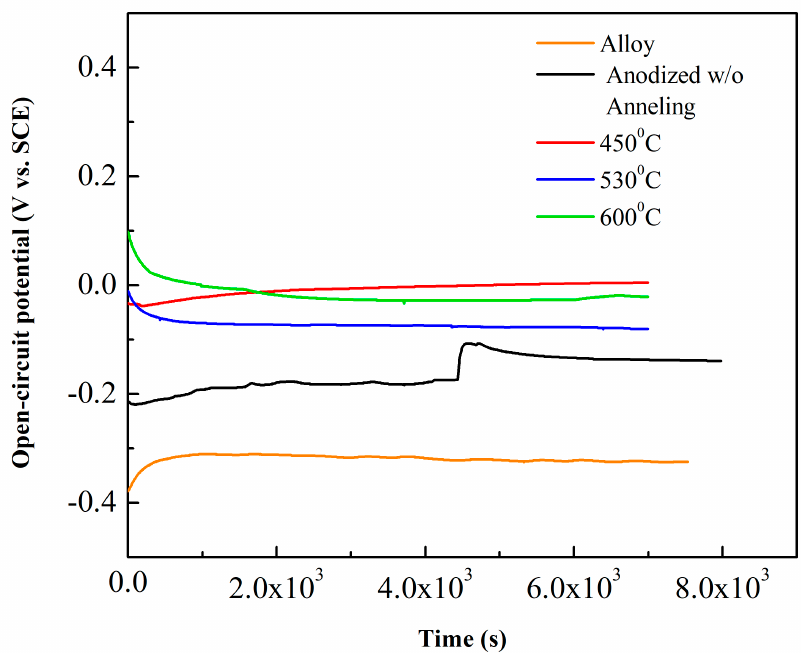
Figure 5. Open circuit potential curves in 0.15 M NaCl + 0.03 M NaF solution at 25 ◦ C.